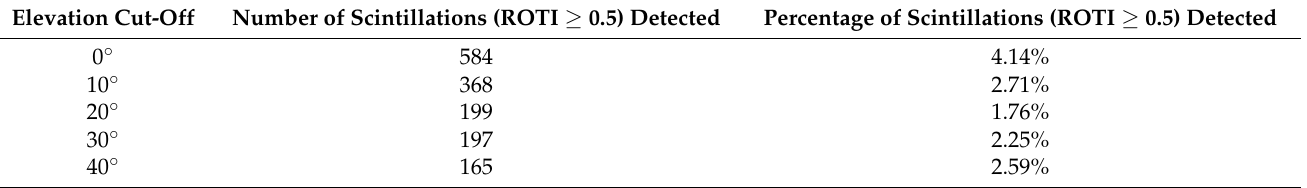
Table 2. Comparison of scintillation events with the different time spans used for ROTI calculations (elevation cut-off is 20°).